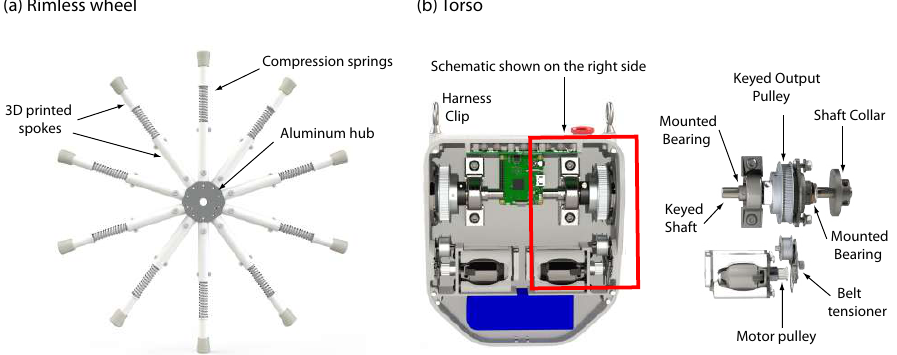
Figure 2. Mechanical Design: ( a ) A single rimless wheel with compliant spokes, and ( b ) torso that includes the transmission using belt drives, the motors, the sensors, and the